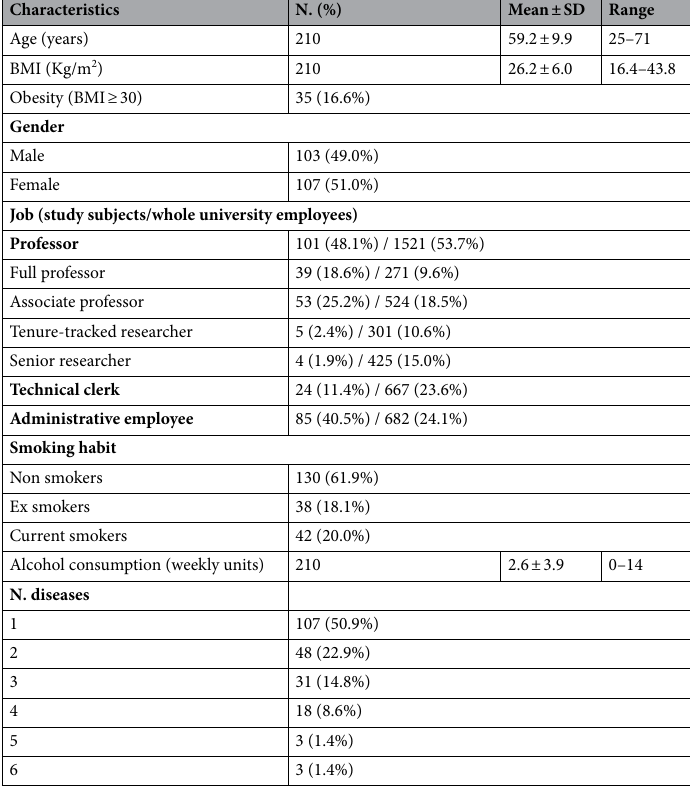
PGWBI validation sample (N.